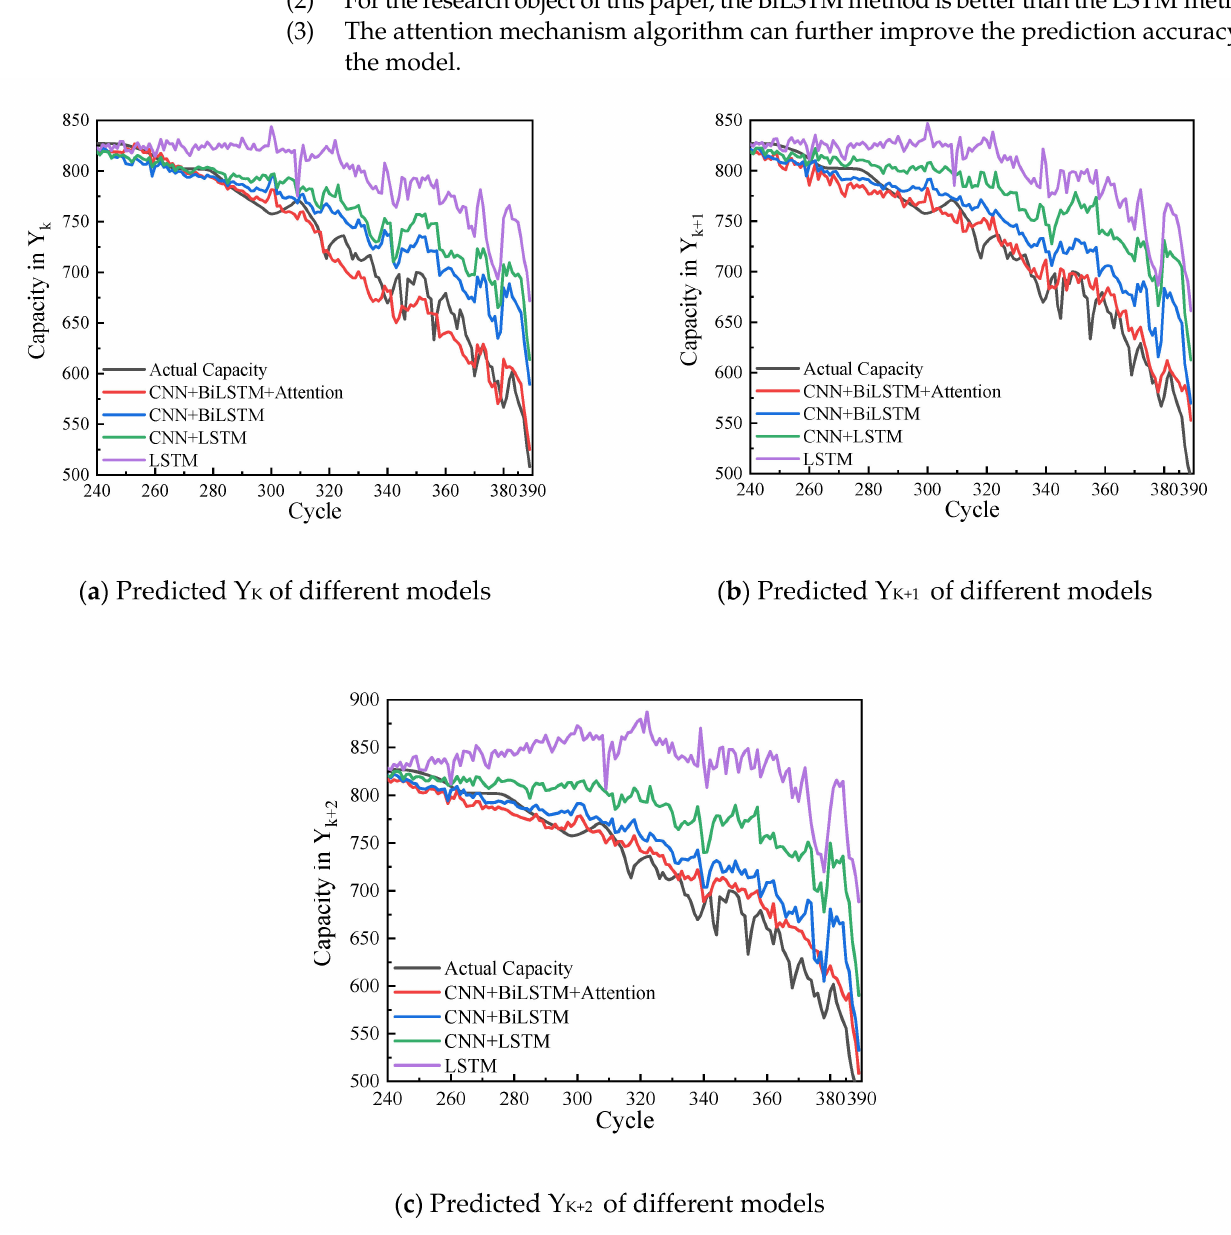
Figure 10. Comparison of forecasting capacity of different models. Taking the 3% error of the rated capacity of the battery as a reference for the upper and lower limits, the comparison between the multi-step predicted capacity of the battery and the actual capacity of the battery is shown in Figure 11. It can be seen that most of the multi-step prediction accuracy of the battery is within the range of the upper and lower limits. Although a small number of capacity prediction results deviate from the upper and lower limits in a small range, they are all less than 5% of the rated capacity error, and the prediction accuracy can meet the actual use